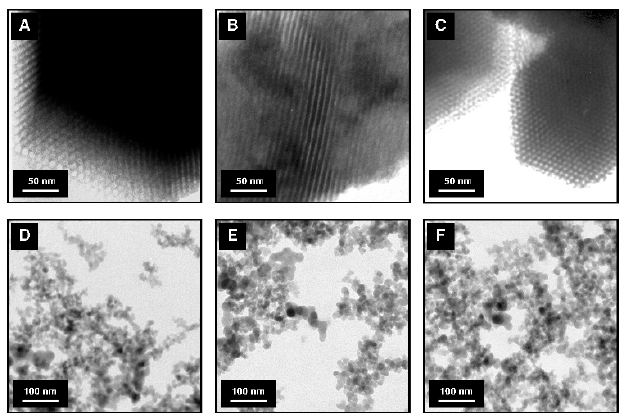
Figure 4. TEM micrographs of pure and modified siliceous adsorbents: ( A ) SBA-15, ( B ) SBA-15-AP, ( C ) SBA-15-MAP, ( D ) Aerosil ® , ( E ) Aer-AP, and ( F ) Aer-MAP.